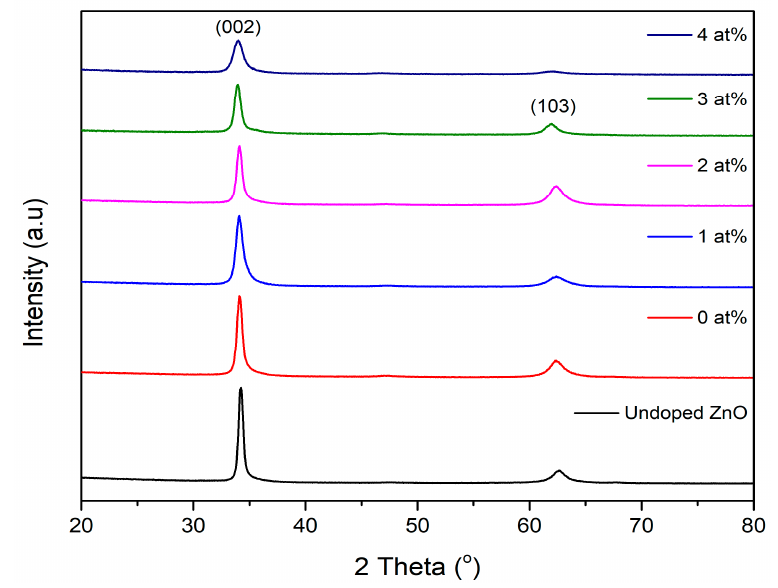
Figure 2. XRD patterns of (Gd, Al) co-doped ZnO films with varied Al concentrations. Table 2. Structural properties of (Gd, Al) co-doped ZnO films with variation of the Al concentra- tion.